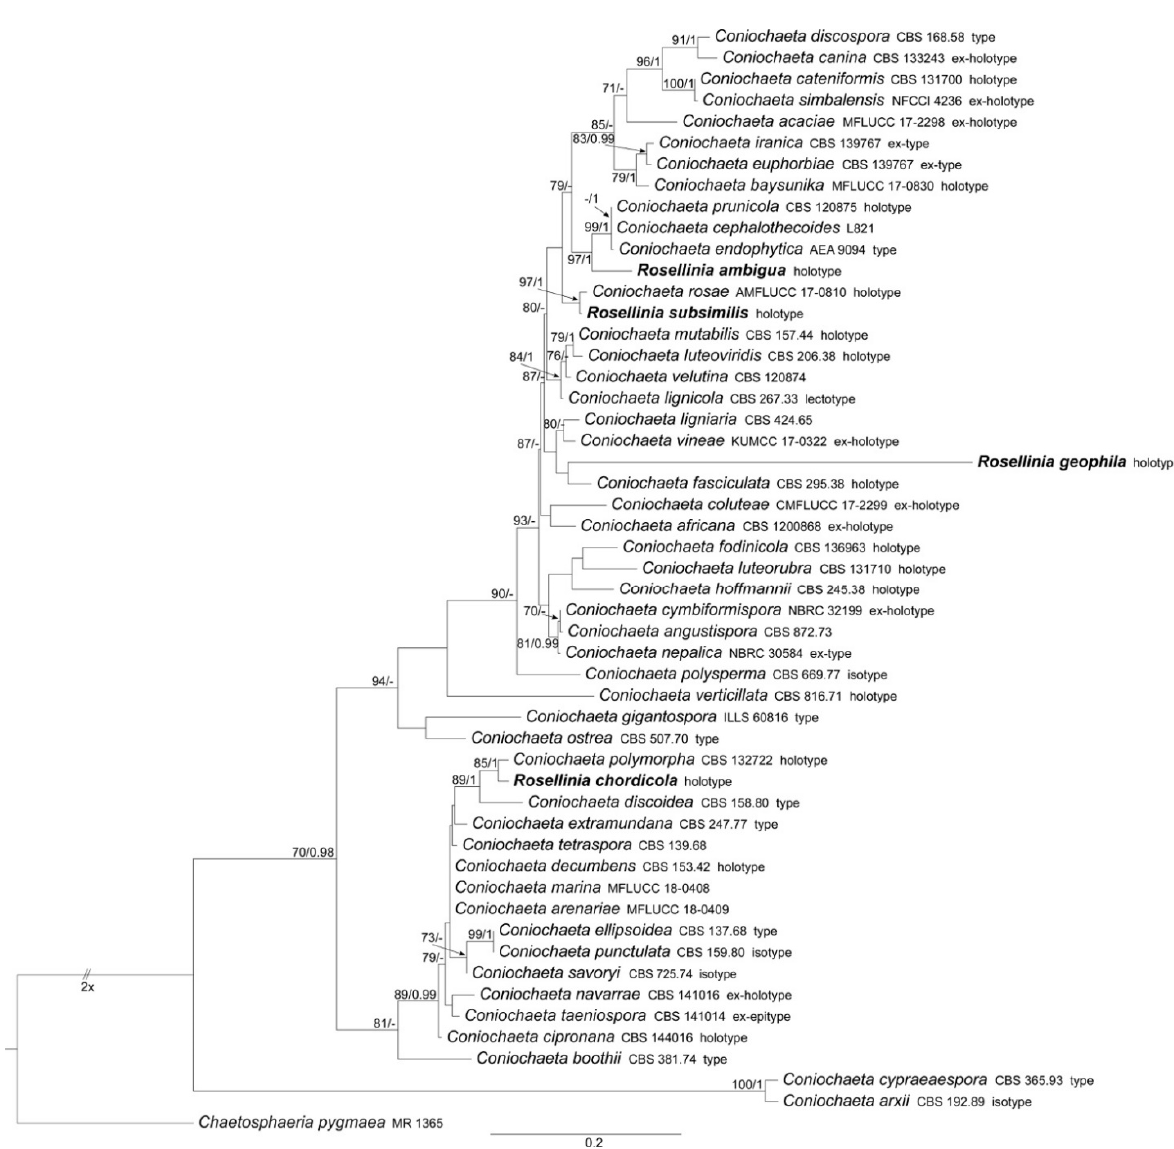
Figure 1. RAxML phylogram obtained from ITS sequences of selected Coniochaeta species. ChaetoScheme 70. (left) and BPP values ≥ 0.95 (right) are shown on the branches. Newly obtained sequences are reported in bold .